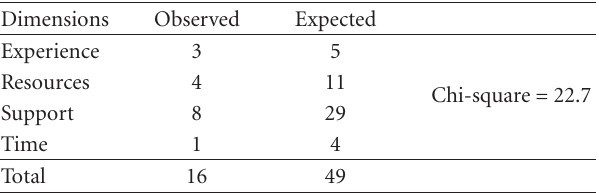
Table 2: The significance di ff erence between observed and expected frequencies in the implementation of PD programs.